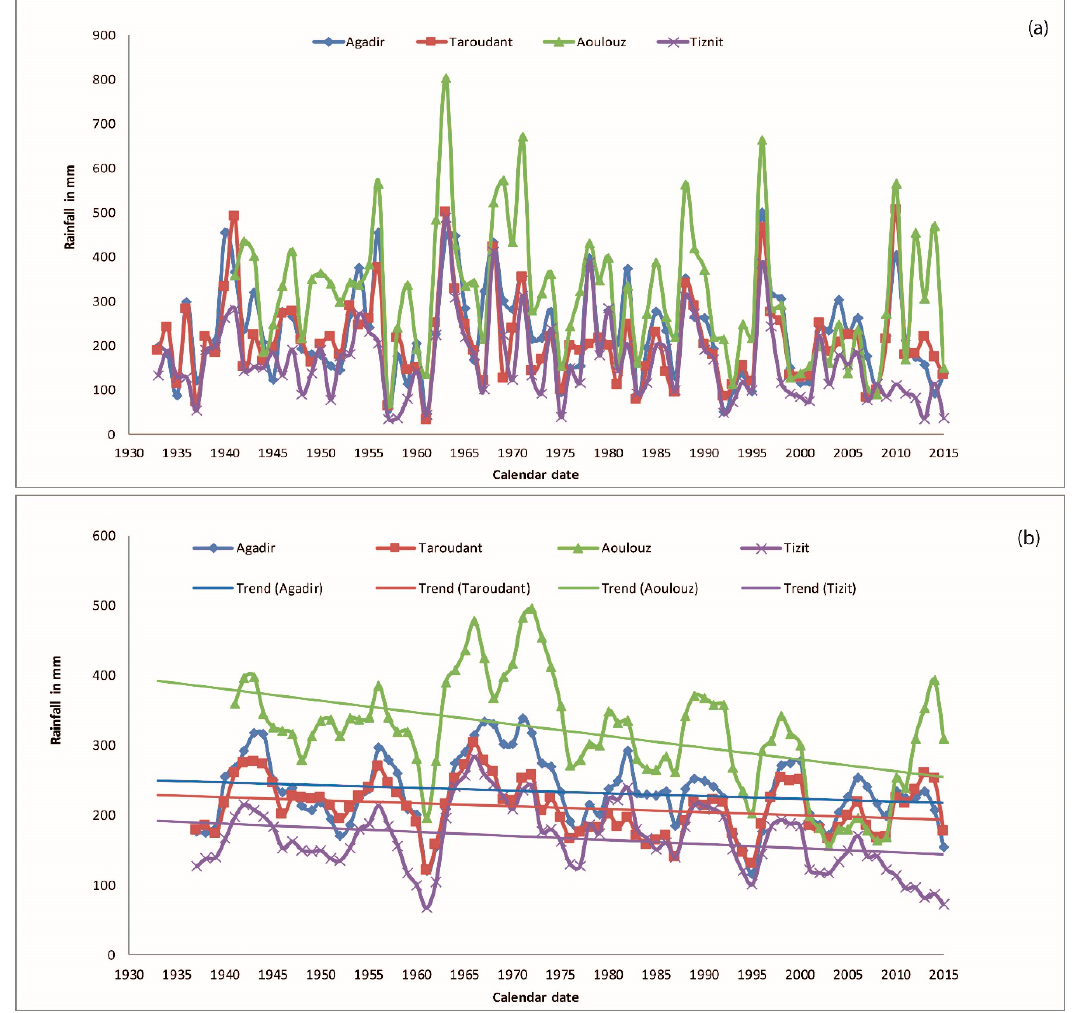
Figure 11. ( a ) Annual mean variation in precipitation and ( b ) 5 years moving average over